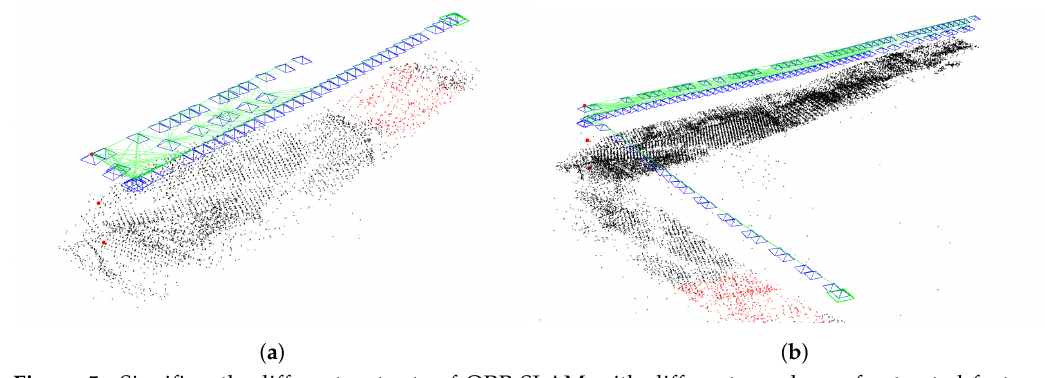
Figure 5. Significantly different outputs of ORB-SLAM with different numbers of extracted features. ( a ) ORB-SLAM with 2000 features. ( b ) ORB-SLAM with 6000